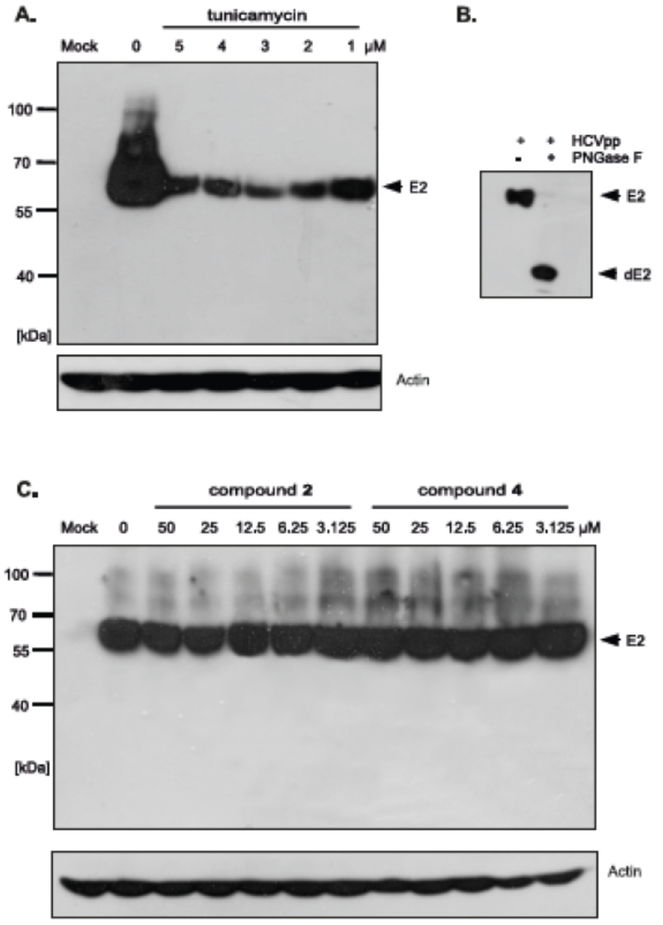
Figure 8. The effect of tunicamycin and uridine derivatives of 2-deoxy sugars on E2 protein accumulation in HEK-293T cells. HEK-293 T cells were transfected with three plasmids to produce HCVpp. 16 h post transfection fresh medium with different doses of tunicamycin ( A ) or compounds 2 and 4 ( C ) were added. After 48 h post-transfection cells were lysed and proteins were separated by SDS–PAGE. Additionally, cell lysates were first digested with peptide:N-glycosidase F (PNGase F) followed by SDS-PAGE ( B ). Western blot analysis was performed using the specific anti-E2 MAb (AP33) and anti-actin monoclonal antibody.